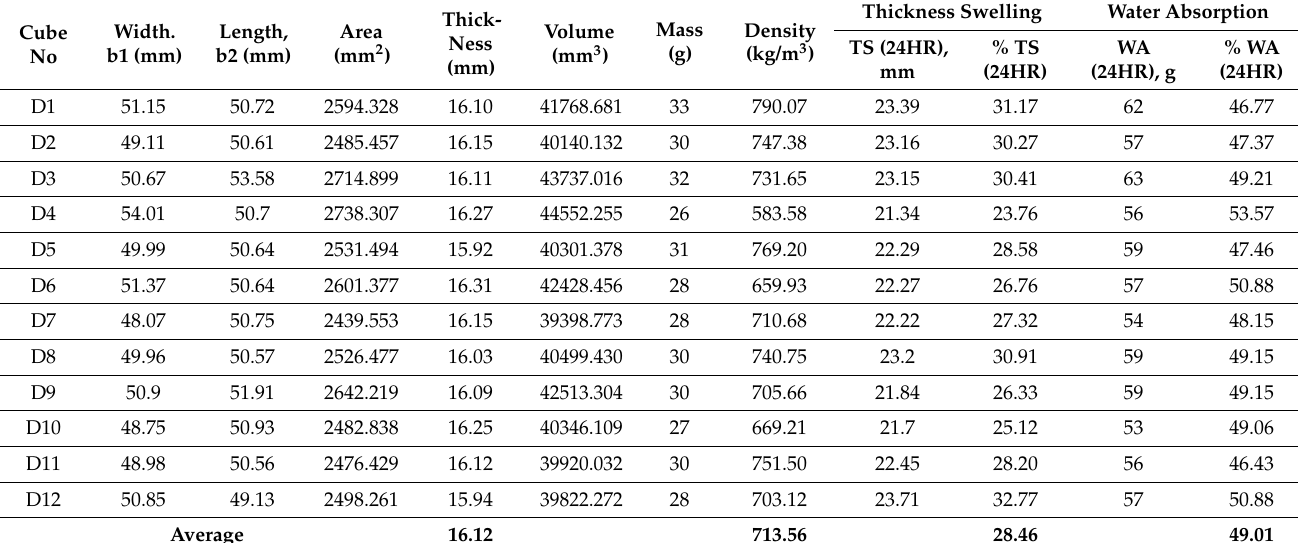
Table 5. Summary on Density, Thickness Swelling and Water Absorption of Test Pieces of All Boards. Table 4. Details of Test Pieces to Determine Density, Thickness Swelling and Water Absorption for Board 100SD:0CF in Thickness Group 16mm.